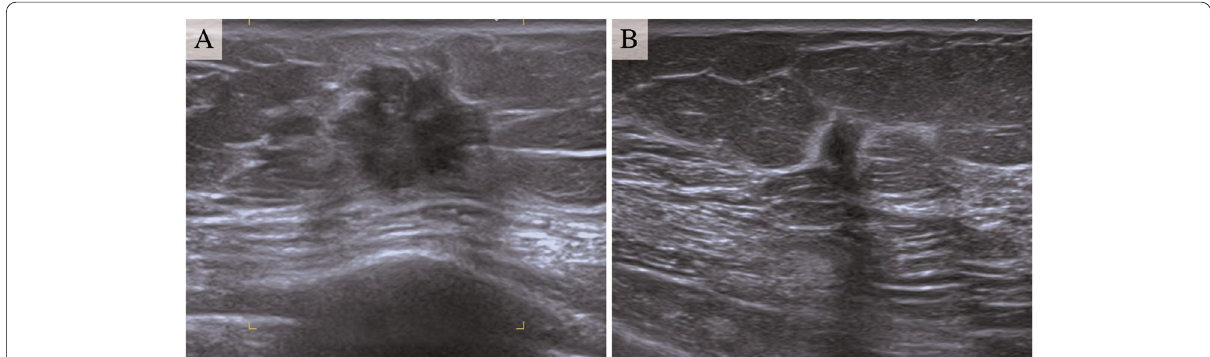
Fig. 1 Ultrasonography Image Of Suspicious Nodular Lesions Identified With PhiΦBreast Model. Solid lesion, round shape, markedly hypoechoic echostructure with irregular and infiltrative margins ( A ). Solid lesion, cuneiform shape, markedly hypoechoic echostructure with blurred margins ( B